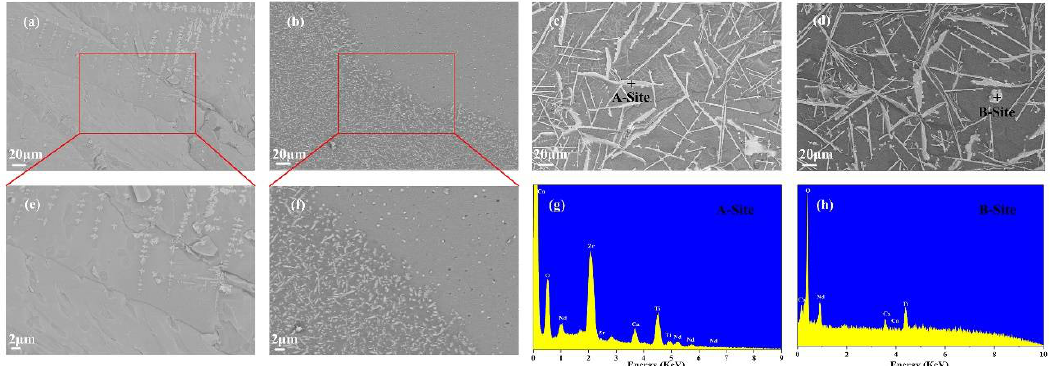
Figure 6. SEM images of the samples with different CTZ content: ( a ) CTZ-20, ( b ) CTZ-30, ( c ) CTZ-40, ( d ) CTZ-50; ( e ) partial enlarged view of CTZ-20, ( f ) partial enlarged view of CTZ-30 ; EDS spectra of CTZ-40 and CTZ-50: ( g ) A-Site, ( h ) B-Site.